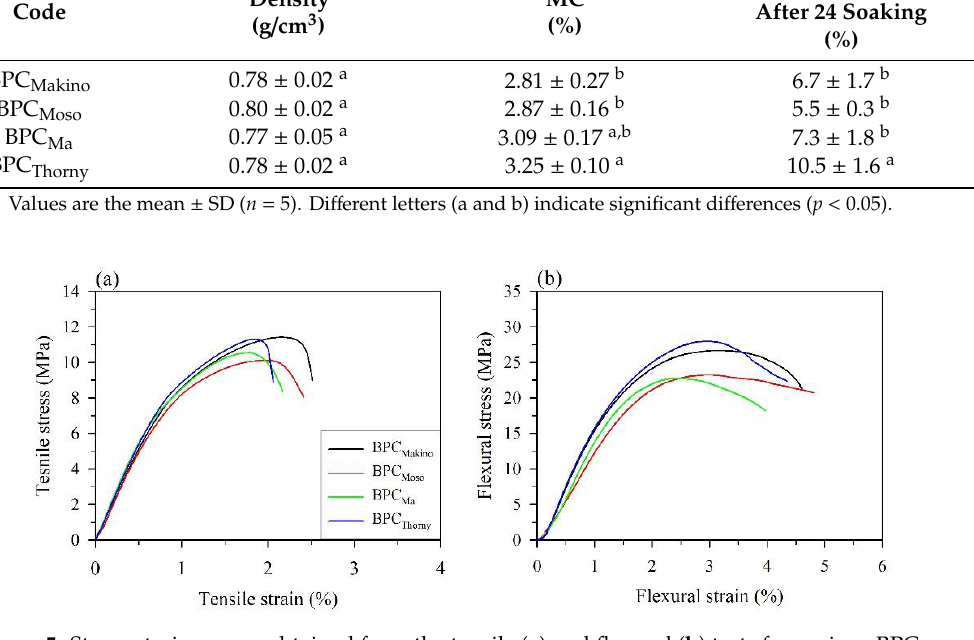
Figure 5. Stress-strain curves obtained from the tensile ( a ) and flexural ( b ) tests for various BPCs. Table 5. Mechanical properties of the BPCs with various